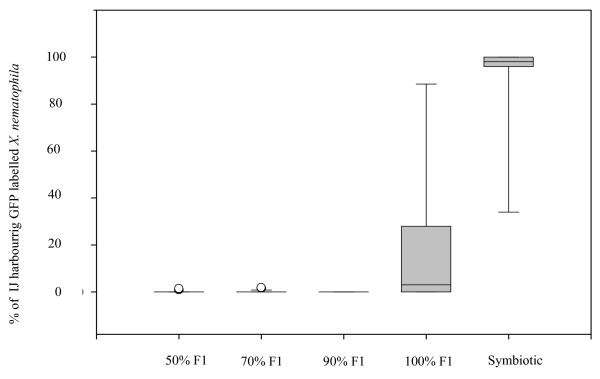
Percentile distribution of the percentages of IJs harbouring GFP labelled X. nematophila. Results are given as box plots, where the horizontal line indicate the median (50th of the data), the bottom and the top of the box indicate the first quartiles (25th of the data) and the third quartiles (75th of the data). The whiskers the range of the data (10th of the data and 90th of the data). Others dots are outliers which are under the 10th percentile of the data or over 90th percentile of the data. The abscissa shows the condition of the initial infection.